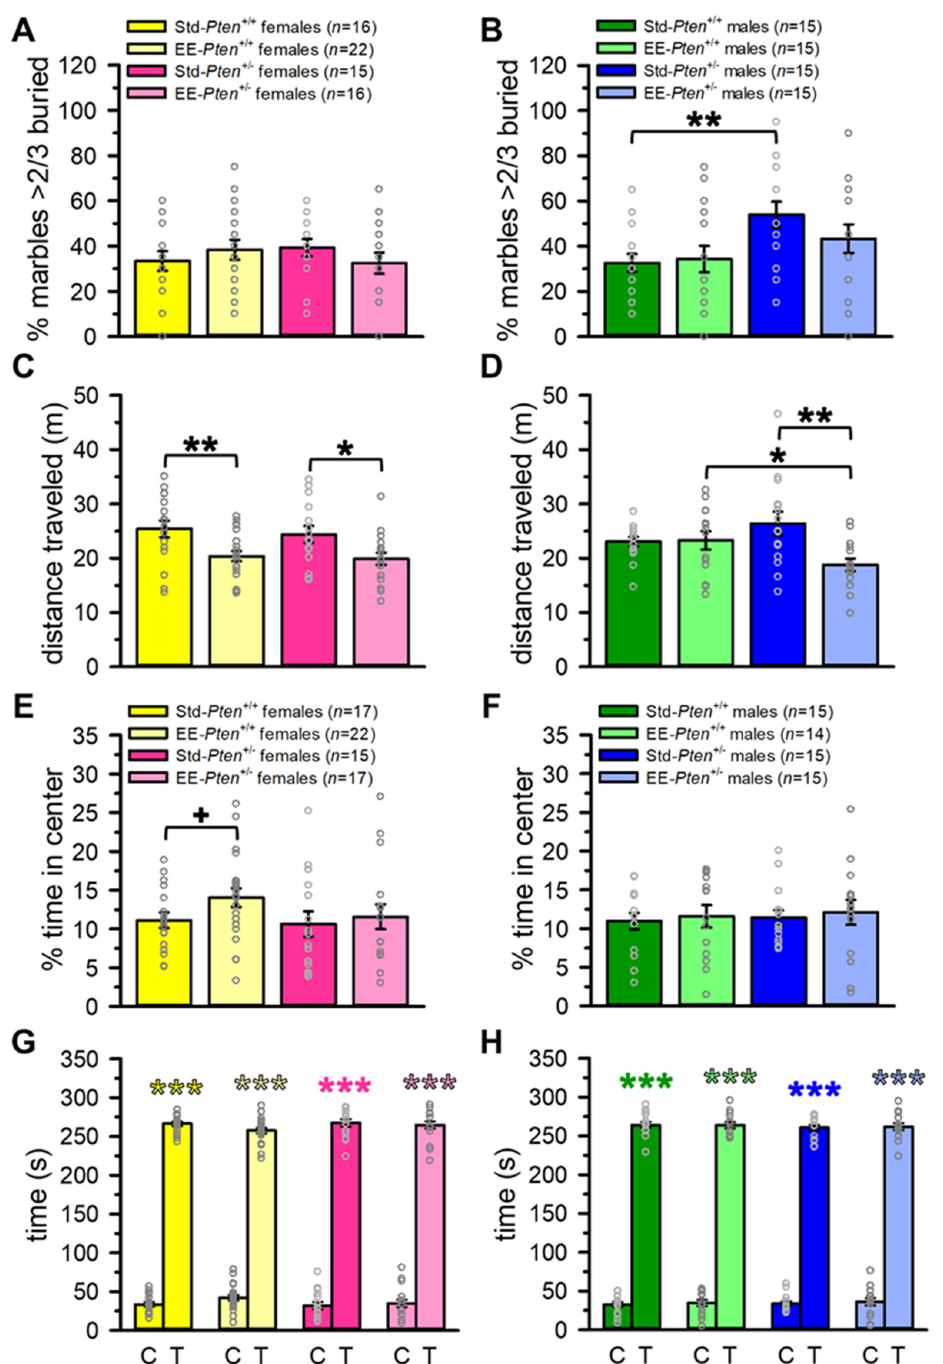
Figure 4. Environmental enrichment rescues Pten +/ − male repetitive behavior phenotype. ( A , B ) Male Std- Pten +/ − mice buried more marbles than Std- Pten +/+ males, but no genotype difference was found in EE males ( B ). Females showed no difference between any groups or conditions ( A ). ( C , D ) EE decreased distance traveled in both genotypes of females ( C ) and Pten +/ − males ( D ), and EE- Pten +/+ males traveled farther than EE- Pten +/ − males ( D ). ( E – H ) Enrichment had a trend to decreasing anxiety in Pten +/+ females ( E ). No other genotype or condition differences were found in anxiety (center time) in females ( E ) or males ( F ), and all female ( G ) and male ( H ) groups spent significantly longer in thigmotaxis than the center of the arena. Mean ± SEM. Black symbols, difference between genotypes or conditions. Colored symbols, difference between center and thigmotaxis time (paired-sample t -test). *** p < 0.001, ** p < 0.01, * p < 0.05, + p < 0.10. C, center of arena; T, thigmotaxis; Std, standard housing; EE, environmental enrichment.